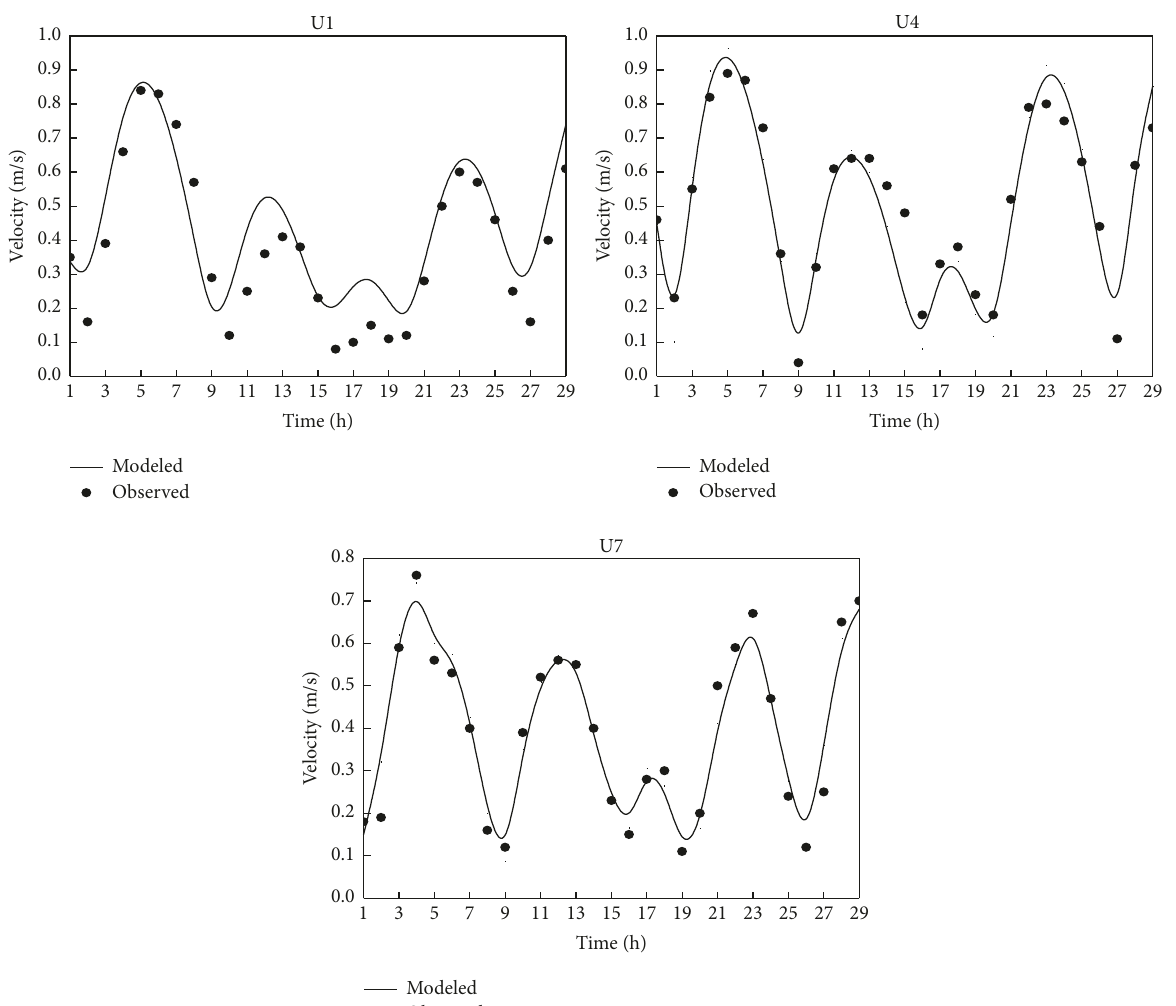
Figure 10: Comparison of flow velocity between the modeled (solid line) and the observed (dots) results at three stations (U1, U4, and